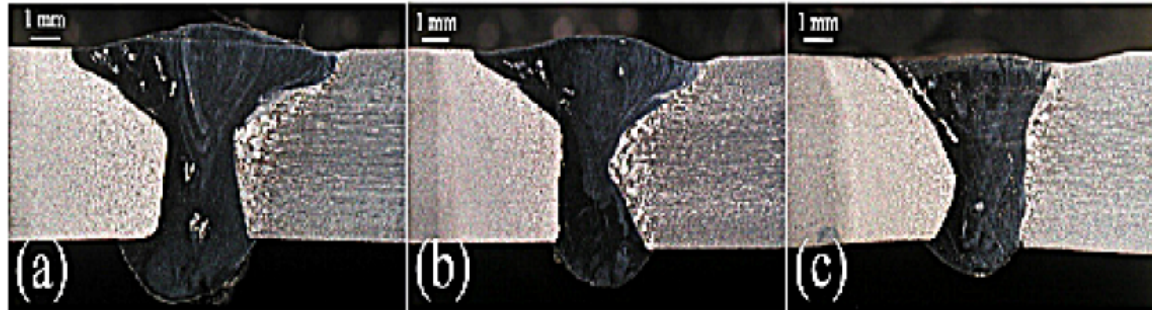
Figure 6: Structure of weld samples of the dissimilar weld of S960/S32205: (a) WS7.1; (b) WS8; (c) WS 9. Reprinted with permission from Tasalloti et al. // Material Characterization, 123 (2016). ©2016 Elsevier Inc. All rights reserved.